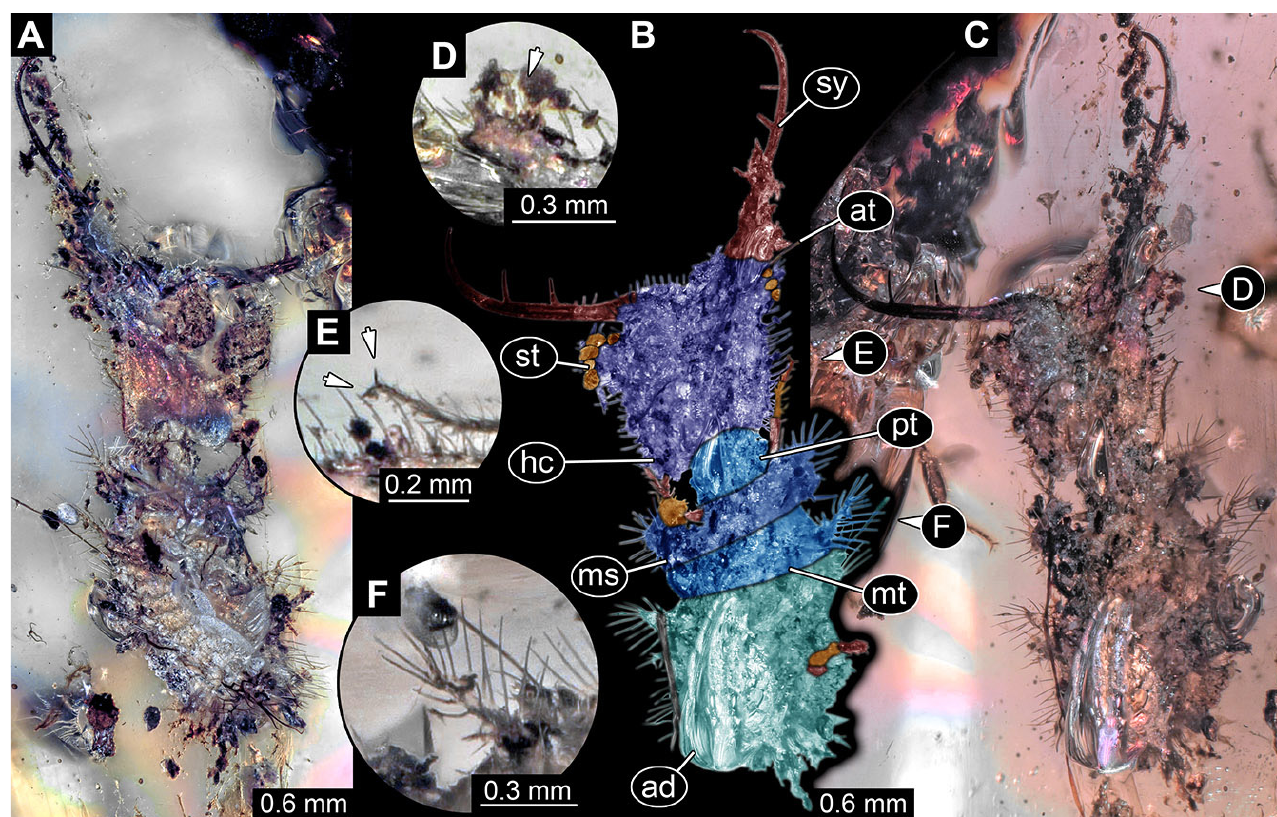
Figure 27. Fossil owllion larva, specimen 3240 (PED 0520), Cretaceous Kachin amber, Myanmar. ( A ) Overview, ventral. ( B ) Color-marked version of ( C ). ( C ) Overview, dorsal. ( D ) Close-up on field of stemmata (arrow). ( E ) Close-up on locomotory appendage with claws (arrows). ( F ) Close-up on dorsal process. Abbreviations: ad = abdomen; at = antenna; hc = head capsule; ms = mesothorax; mt = metathorax; pt = prothorax; st = stemmata; sy = stylet.